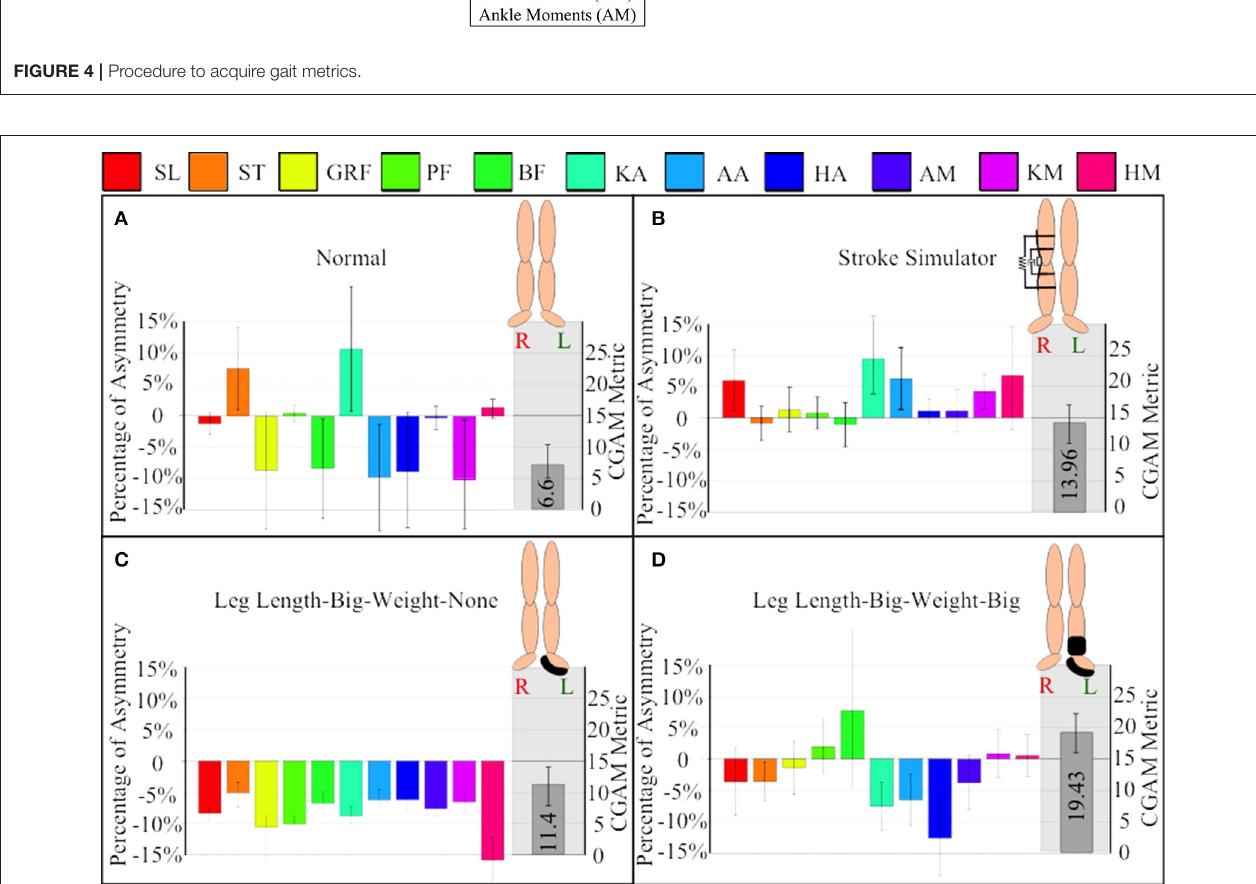
FIGURE 5 | Comparing variation of mean, standard deviation, and CGAM metric among perturbations. (A) Normal walking without any alterations, (B) walking with SS or the variable stiffness and damping knee orthosis, (C) walking with big leg length and no weight addition at the ankles, and (D) walking with big leg length and weight. SL, step length; ST, step time; GRF, ground reaction forces; PF, push off forces; BF, braking forces; KA, knee angle; AA, ankle angle; HA, hip angle; AM, ankle moment; KM, knee moment, and HM, hip moment.